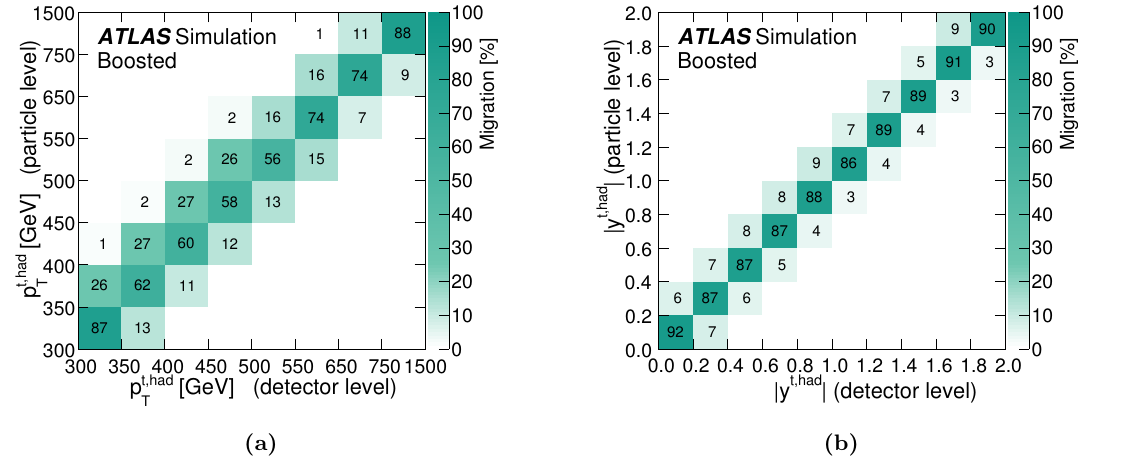
Figure 10. Particle-to-detector-level migration matrices for (a) the hadronic top-quark transverse momentum and (b) the absolute value of its rapidity, in the boosted topology. Powheg + Pythia6 is used to model the t (cid:22) t process and matrices are normalised so that the sum over the detector level yields 100%. The empty bins either contain no events or the fraction of events is less than